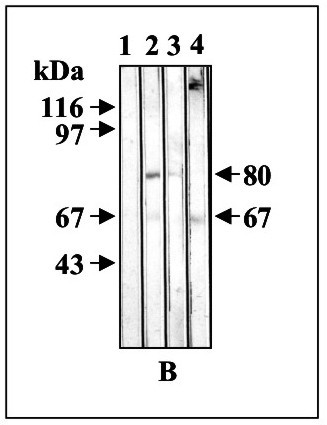
Immunoblotting of total C6/36 extracts. Extracts from C6/36 cells treated as in Figure 2 were tested with pre-immune mouse serum (lane 1), anti-EP (lane 2), anti-R80 (lane 3) or anti-R67 (lane 4). Molecular weight markers are shown on the left side and the proteins detected by the antibodies on the right side.